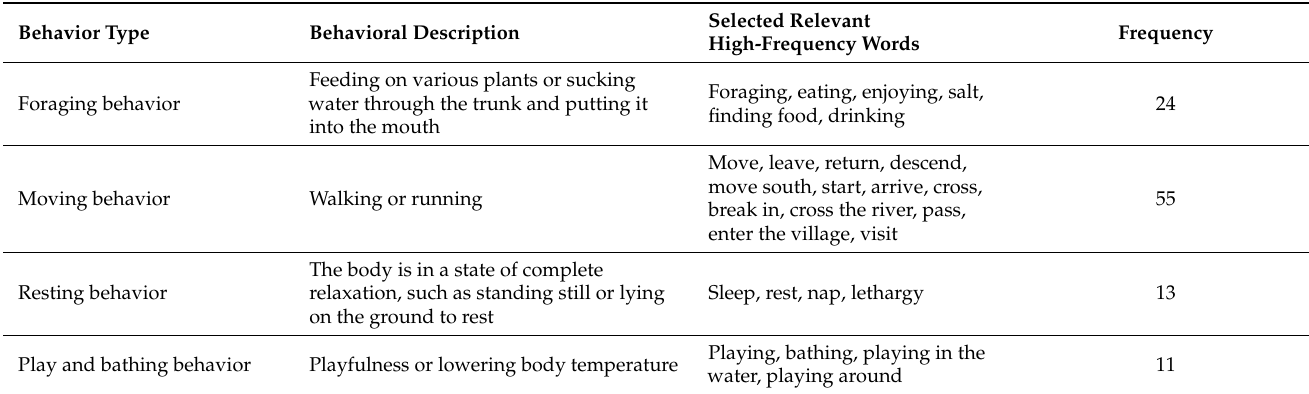
Table 6. Behaviors of Asian elephants and their impact on